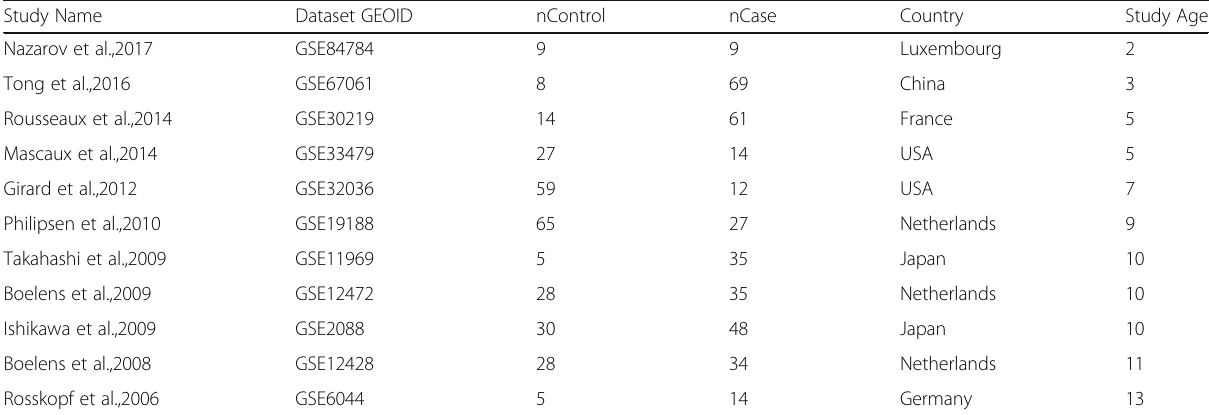
Table 1 Datasets selection for mega-analysis